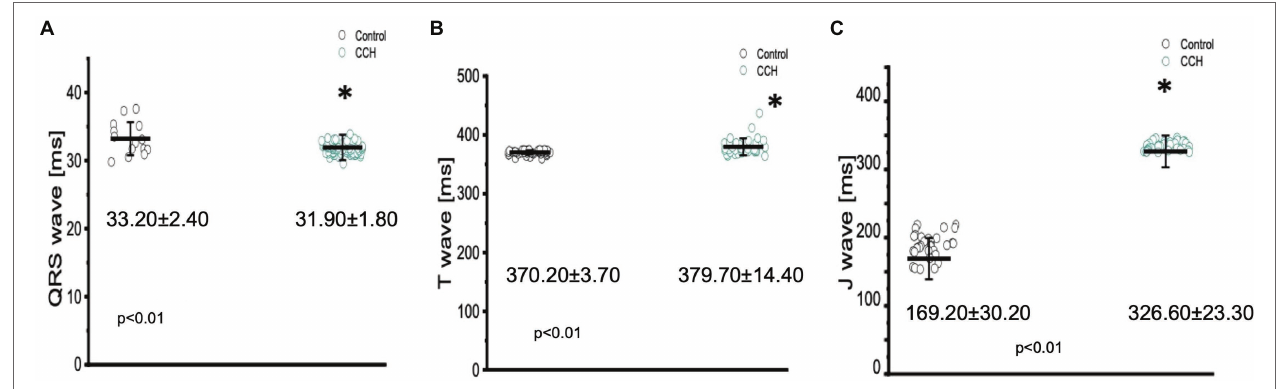
FIGURE 10 | Perfusion with 5 μ m carbamylcholine significantly altered the time course of all three components in the Goldfish electrocardiogram. The duration of the QRS significantly decreased from 33.20 ± 2.40 ms to 31.90 ± 1.80 ms ( p < 0.01, n = 15 for the control, n = 59 for CCH, N = 6; A ), the T wave increased from 370.20 ± 3.70 ms to 379.70 ± 14.40 ms ( p < 0.01, n = 31 for the control, n = 36 for CCH. N = 6; B ), and the J wave show a significant increase from 169.20 ± 30.20 ms to 326.60 ± 23.30 ms ( p < 0.01, n = 32 for the control, n = 31 for CCH. N = 6; C ). * Denotes a significant difference between the two distributions. The data are